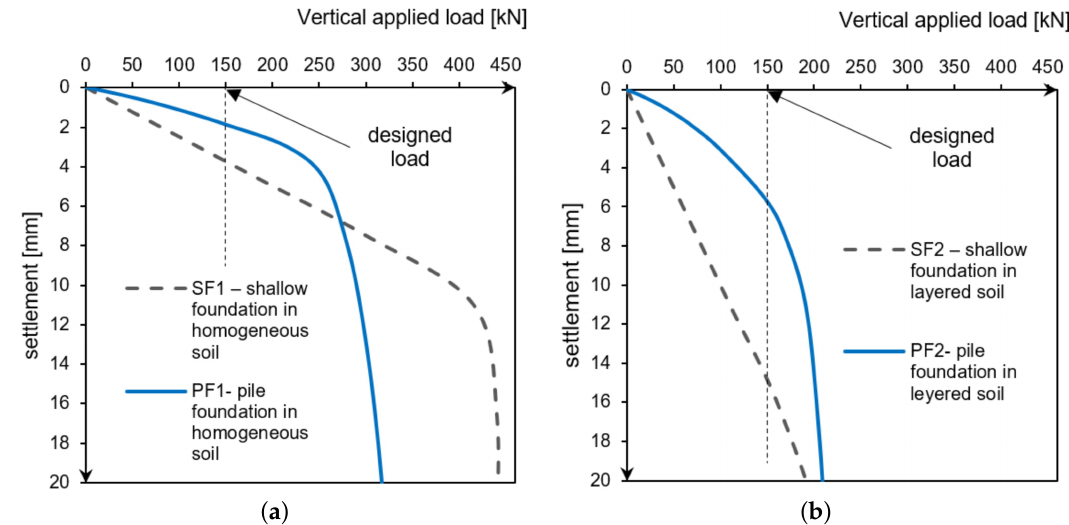
Figure 19. The load–foundation settlement relationship ( a ) for homogeneous soil, ( b ) for layered soil (with a weaker layer located directly below the direct